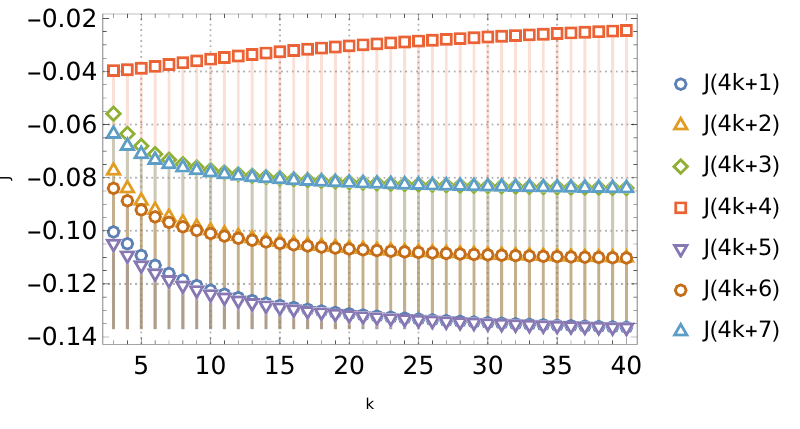
Figure 1 . Numerical result of the integrals J ( n ) ; for n = 4 k + 4 , the plot corresponds to J reg ( n )